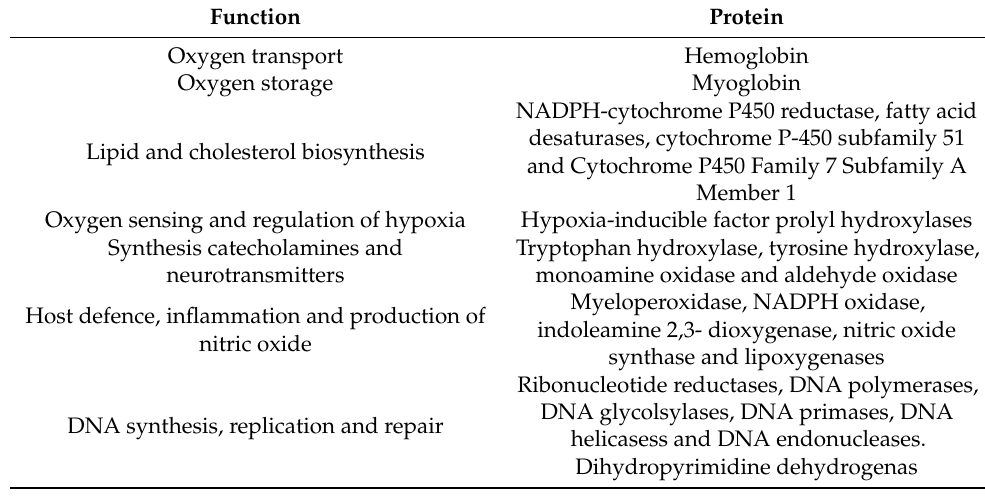
Table 1. Overview of proteins that require iron to function